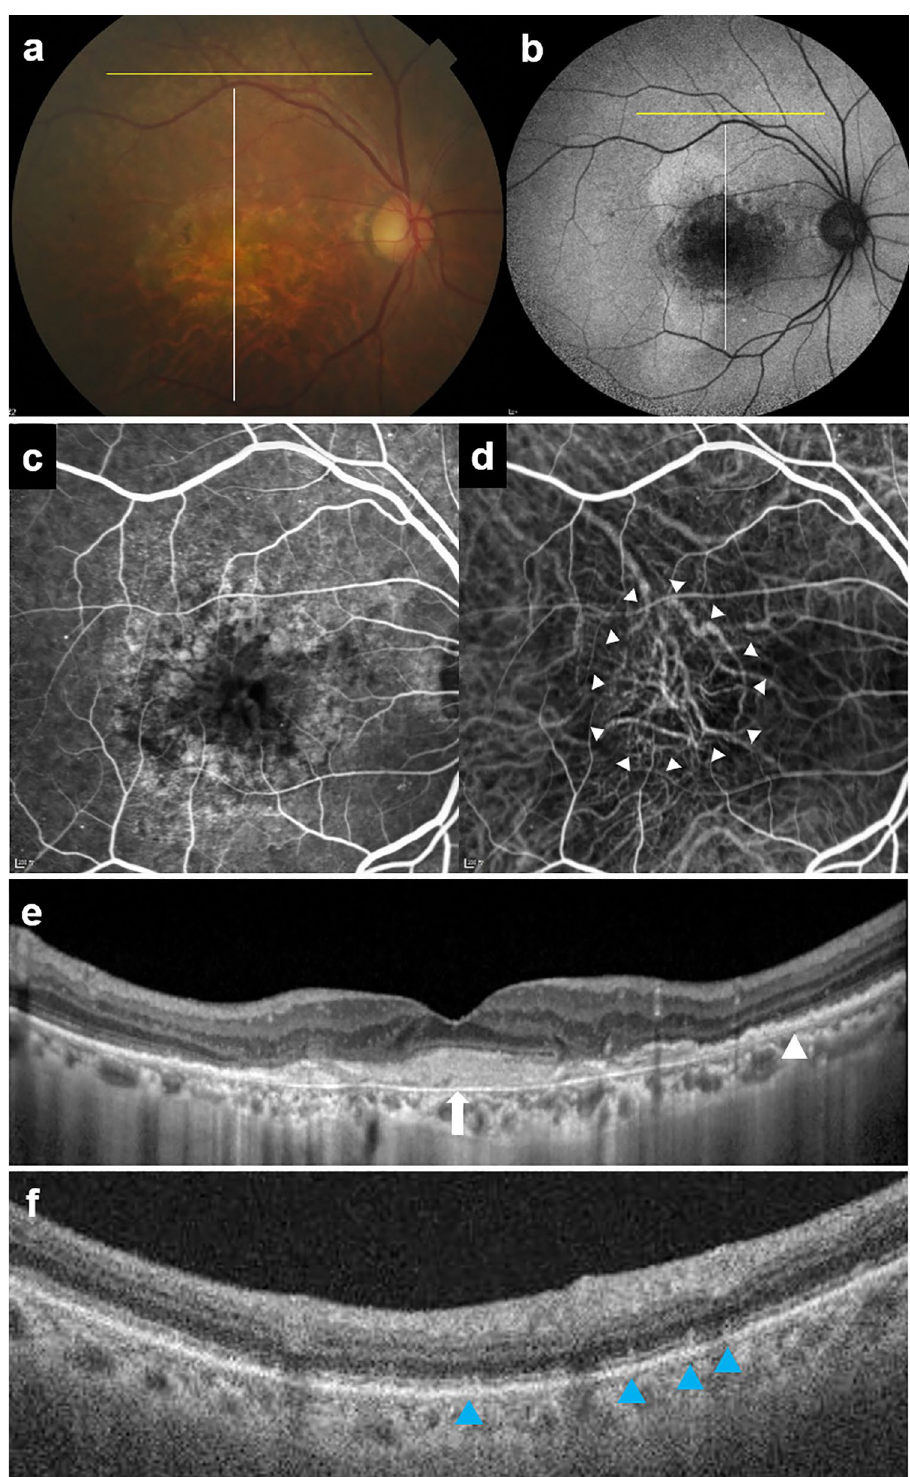
Figure 4. Multimodal imagings of an 80-year-old woman who had macular neovascularization and non-proliferative diabetic retinopathy (Case 5). ( a ) Multiple deposits of various sizes are present at the macula and the area superior to the macula in color fundus photography. Macular hypopigmentation is also observed. ( b ) Fundus autofluorescence imaging shows floodplain hyperautofluorescence. ( c ) Fluorescein angiography of the venous phase shows perifoveal hyperfluorescent areas, microaneurysms, and small hyperfluorescent spots corresponding to cuticular drusen. ( d ) Indocyanine green angiography (ICGA) shows neovascularization (white arrowheads). ( e ) Optical coherence tomography (OCT) scan, obtained at the location of the white line in A and B, shows saw-tooth elevation of retinal pigment epithelium (white arrowhead), subretinal hyperreflective material (white arrow), and pigment epithelial detachment. ( f ) OCT scan, obtained at the position of the yellow line in A and B, shows subretinal deposits corresponding to reticular pseudodrusen (blue